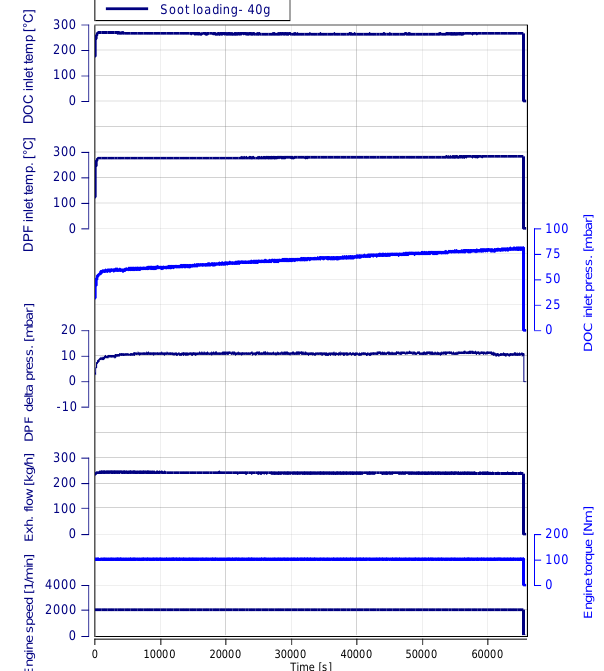
Fig. 13. Filter loading phase for active